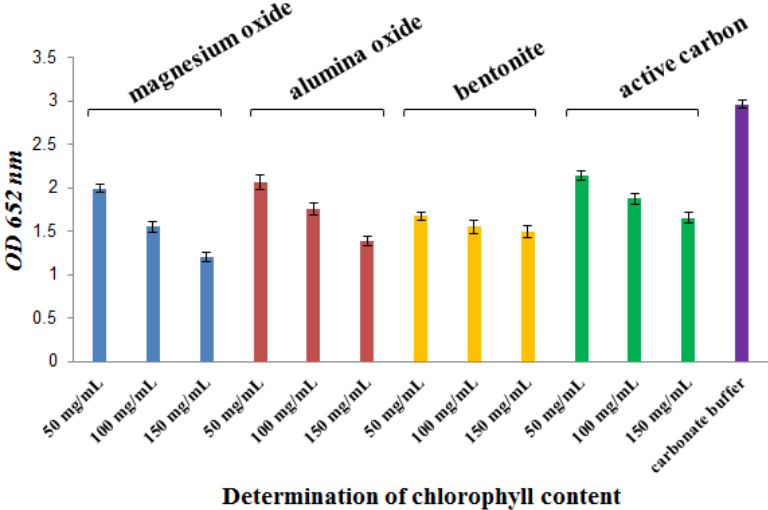
Figure 2. Determination of chlorophyll content in several reagents. Using the SPSS 11.5 software [24], data were statistically analyzed by ANOVA (least significant difference).